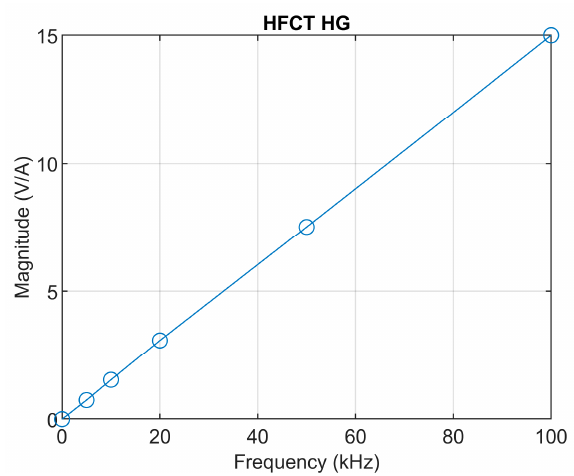
Figure 12. HFCT_HG sensor low-frequency magnitude response.